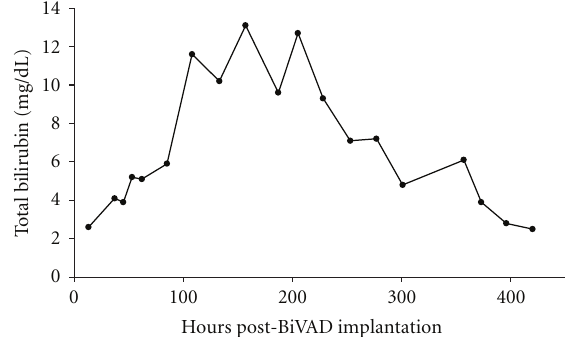
Figure 2: Total bilirubin (mg/dL) following biventricular assist device (BiVAD) implantation.